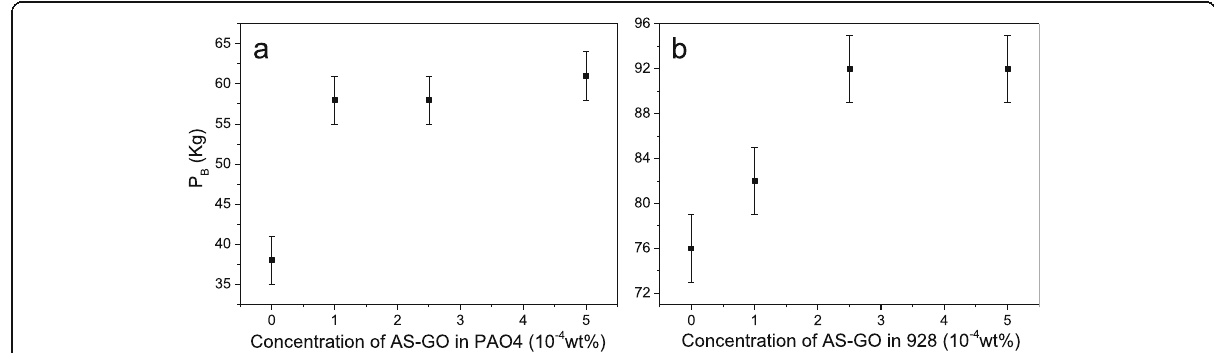
Fig. 9 a , b The maximum nonseizure load (PB) value while SA-GO (prepared by sulfur-doped GO and octylamine, the oxidation time of the GO is 24 h) is applied as lubrication additive with certain concentration in PAO4 ( a ) and 928 ( b )